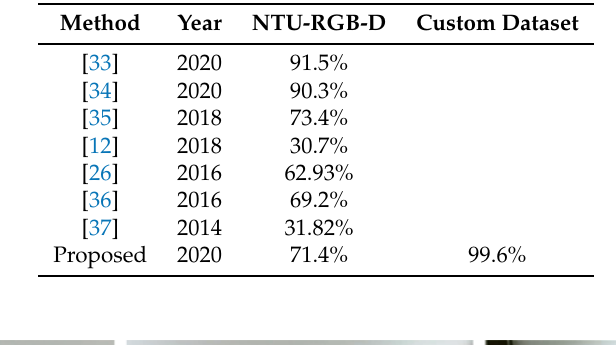
Table 5. Experimental comparison with human action recognition methods based on the recent survey by Zhang et al. [32]. The proposed method does not utilize depth information from the NTU-RGB-D dataset.